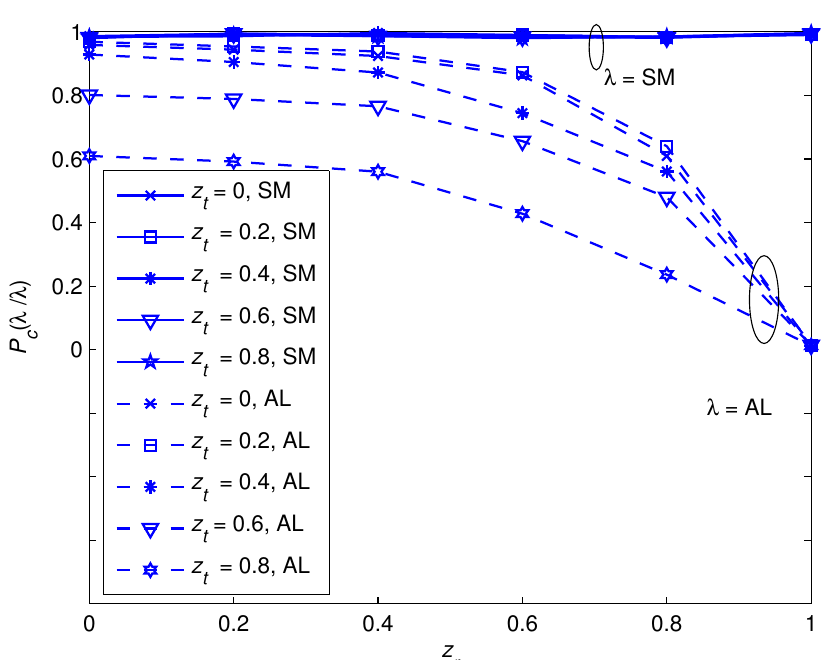
Figure 5. Effect of z t and z r on the classification performance of combiner and detector 1 with = 10 − 3 f n d